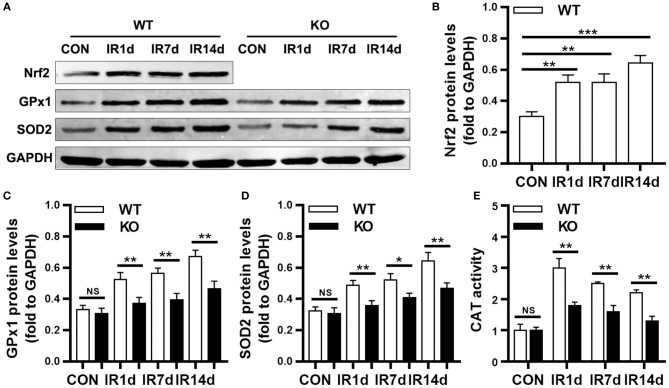
Nrf2 knockout suppressed radiation-induced antioxidative proteins. (A–D) Nrf2 deficiency inhibitd radiation induced Nrf2, GPx1, and SOD2 in lung tissues as meaured by Western blot. (E) Nrf2 knockout reduced radiation-induced activation of CAT. n = 6. NSRepresents no statistical difference (P > 0.05). *P < 0.05; **P < 0.01; ***P < 0.001. Every experiment was repeated for 3 times. The data was shown as mean ± SD and the representative figures were presented here.